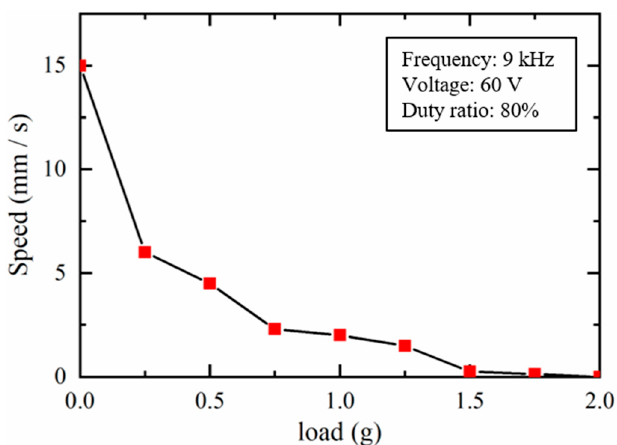
Figure 19. Load Capacity of the slider 1.